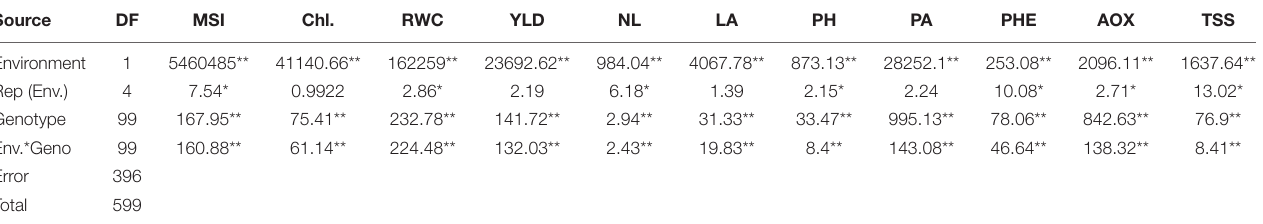
TABLE 3 | Combined ANOVA (mean square) for physiological, biochemical and drought stress indices under well-watered and stress condition.